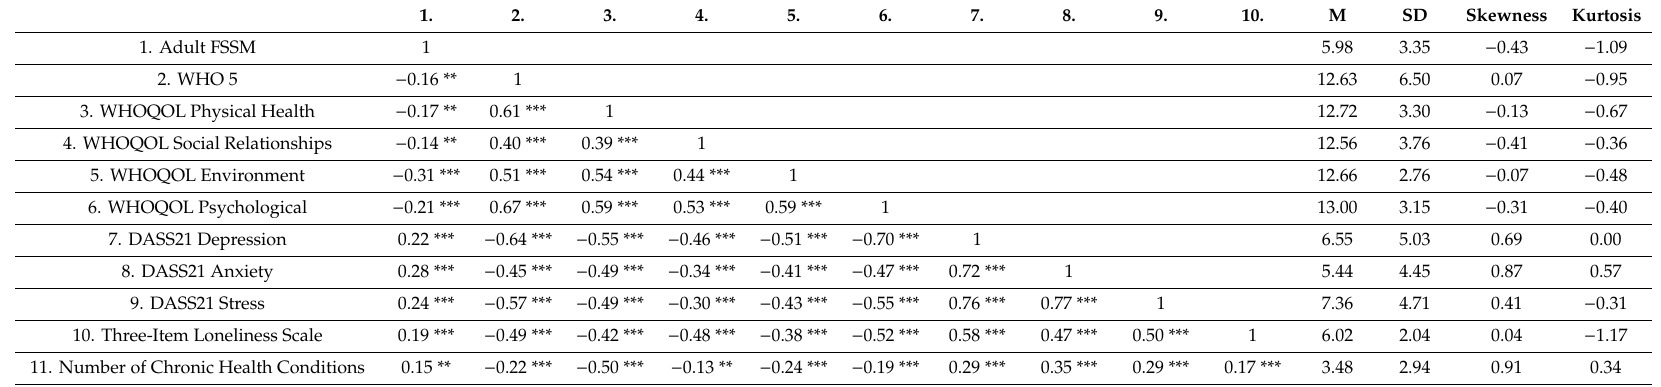
Table 4. Pearson correlations and associated descriptive statistics for World Health Organization (WHO)-5 Wellbeing Index 5, WHO Quality of Life—Brief (WHOQOL), DASS-21 and chronic health